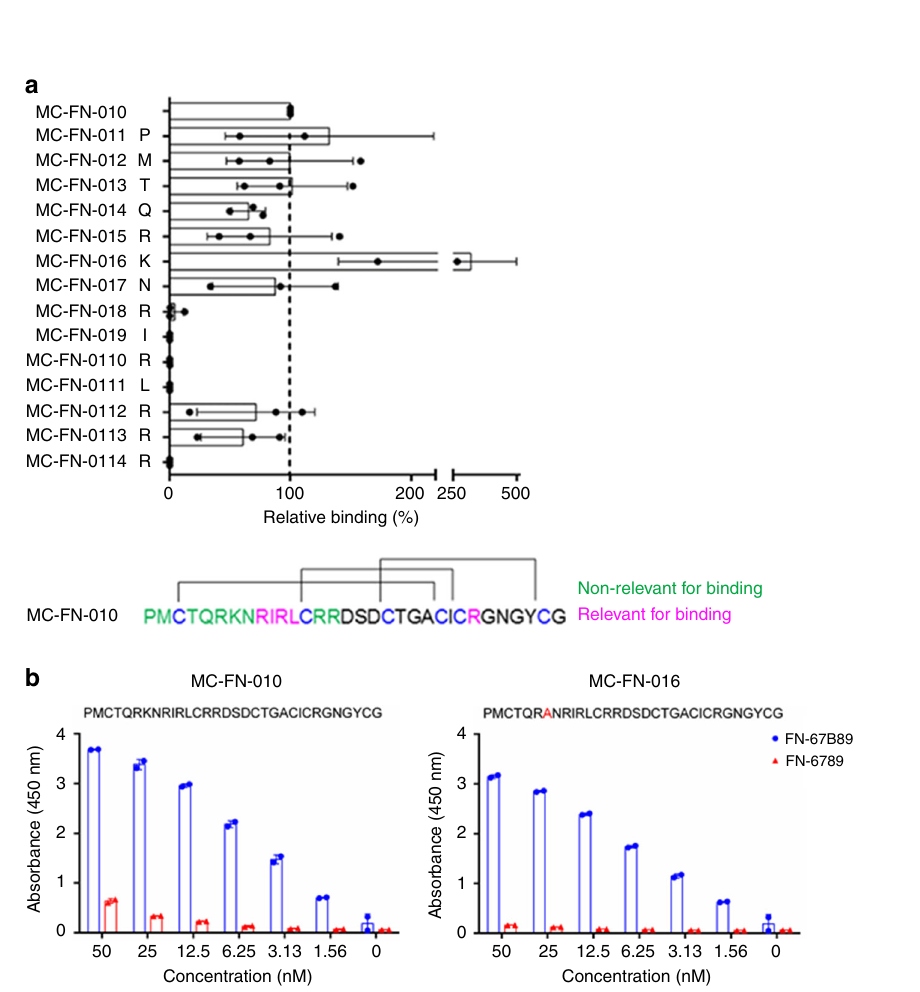
Fig. 2 Discovery of cystine-knot miniproteins with speci fi c binding to EDB. a EDB-containing protein fragments used in this study. The EDB domain distinguishes the oncofetal variant of fi bronectin from the ubiquitously expressed fi bronectin. FN-B (single domain), FN-67B89 (EDB fl anked by the naturally surrounding type III domains), FN-B(8 – 14) (EDB protein with its C-terminal domains 8 – 13 and a part of domain 14), T7-His-TEV-B (N-terminally tagged EDB domain), and FN-6789 (the type III domains 6 – 9 without EDB). b ELISA-based speci fi city analysis of enriched cystine-knot miniproteins. In all, 200 nM of each Trx-cystine-knot miniproteins were applied to immobilized FN-B and FN-67B89 target proteins and to control proteins FN-6789, streptavidin, milk powder, and BSA (coated at 1 µ g/well). Data are shown as mean ± SD. c EDB-binding curves of Trx-cystine-knot miniproteins were generated against FN-B and FN-67B89 targets and against FN-6789 control protein (coated at 1 µ g/well). Binding was detected with an HRP-conjugated anti-S-tag antibody. ELISA was performed in duplicates in single measurement and with MC-Myc-010, harboring a Myc epitope in loop 1, serving as a negative control. The apparent KD-value was calculated based on non-linear regression fi tting curves. d SPR sensorgrams of a multi-cycle kinetic binding analysis of selected cystine-knot miniproteins. Biotinylated FN-67B89 was captured on a streptavidin sensor chip and untagged cystine-knot miniproteins were analyzed with concentrations ranging from 50 to 1000 nM (curves from bottom down to top). The curves were referenced to a blank streptavidin control fl ow cell. Source data are provided as a Source Data fi le.